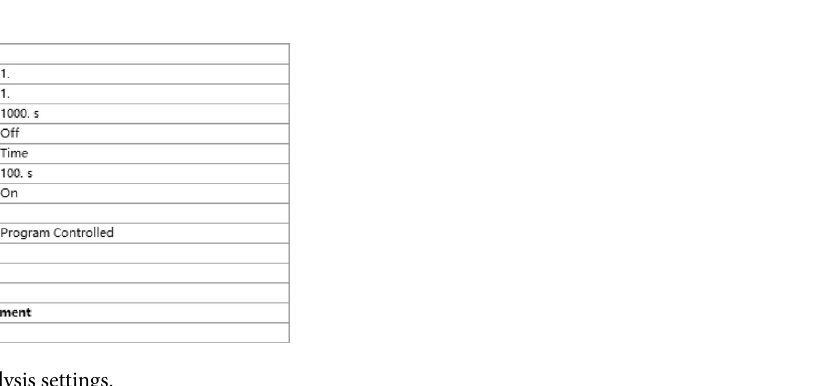
Figure 7. Analysis